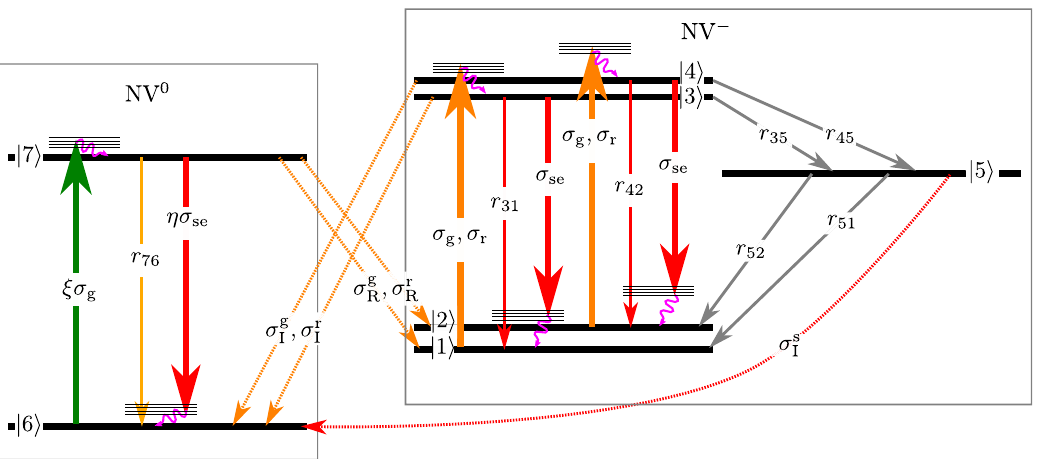
Figure 5: Nitrogen-vacancy (NV) centre model for explaining amplification. Levels 1 – 5 belong to NV − and six and seven belong to NV 0 . In the NV − ,1and2respectivelyrepresent m s =0and m s = ± 1,respectively,ofthegroundstate,and3and4respectivelyrepresent m s =0and m s = ± 1, respectively, of the excited state. Five represent the singlet level of the NV − centre. In the case of NV 0 , it has only the ground state (6) and excited state (7). The orange arrows represent transitions due to both green and red wavelengths. The solid orange line represents the pumping rate, whereas the dotted one represents the ionisation and recombination transitions. The thin and thick solid red arrows represent spontaneous and stimulated transitions. The grey arrows represent intersystem crossing (ISC) transitions, and curly magenta arrows representphonondecays.ThegreenarrowrepresentsthepumpingrateofNV 0 bythegreenwavelength.Thetransitionratesofeachtransition are shown on each corresponding